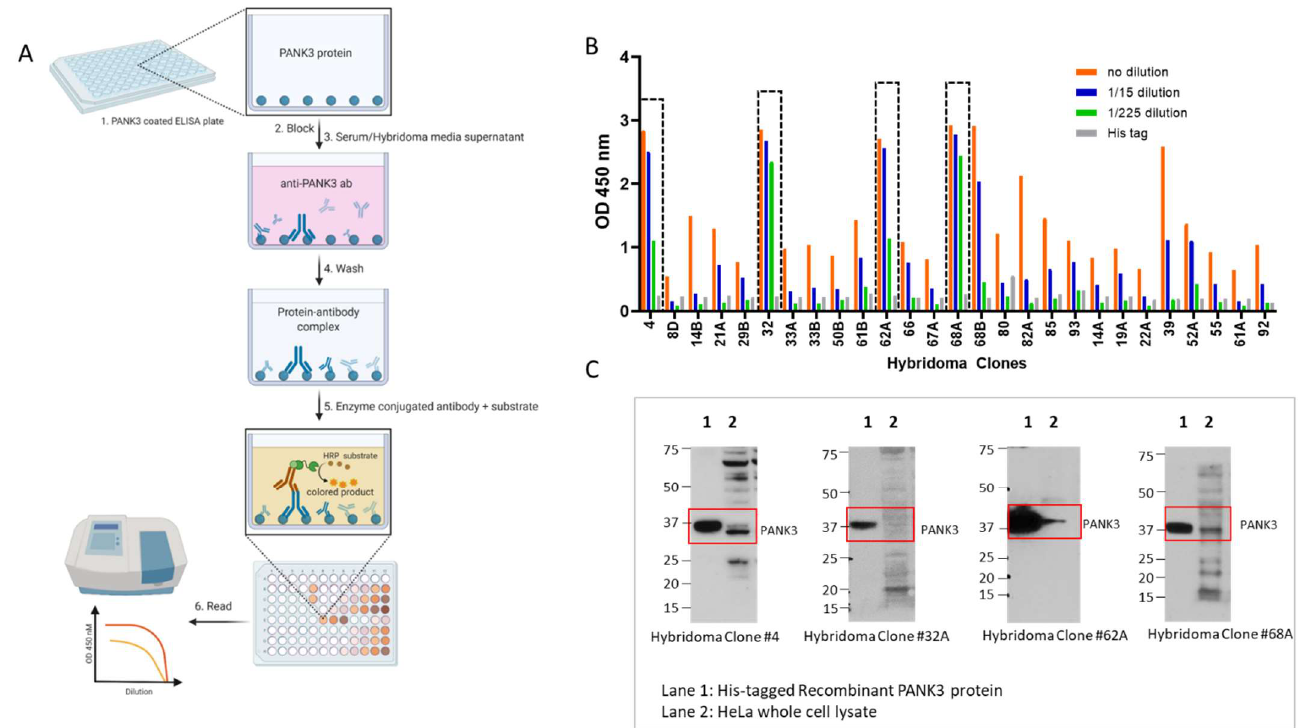
Figure 4. Quantification of PANK3 antibody levels in media supernatant of hybridoma clones. ( A ) Schematic showing the detection of PANK3 protein by ELISA. Briefly, ELISA plates were coated with recombinant PANK3 protein and media supernatant (primary antibody) isolated from different hybridoma clones or the serum extracted from the immunized mice were added to the wells. An HRP-linked secondary antibody was added to detect the PANK3 antibody bound to the immobilized PANK3 protein on the well. Addition of the substrate yielded a color change and the absorbance was quantified using a spectrophotometer. ( B ) Absorbance values of the medium supernatant (1:15 serial dilutions) isolated from different hybridoma clones. Only 14 clones out of 27 are shown in the graph (see Supplementary Material for all 27 clones). ( C ) Immunoblot showing the four antibody clones that were selected for further purification. The antibody clones were able to identify the recombinant protein, but the endogenous protein band in the HeLa cell lysate was convoluted by overlapping non-specific bands.